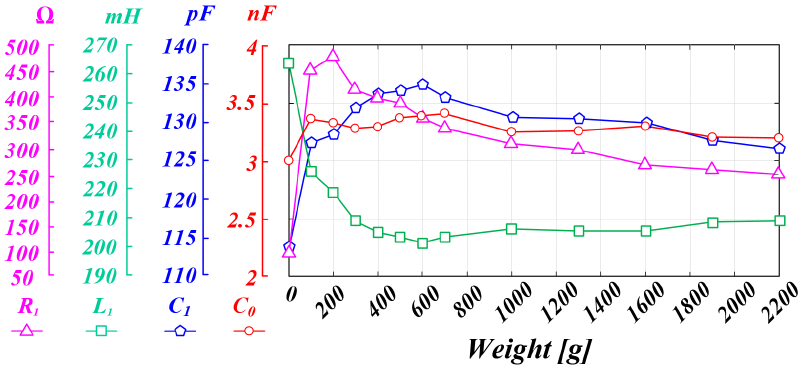
Figure 3. PT parameter change characteristic graph according to pressure fluctuation.